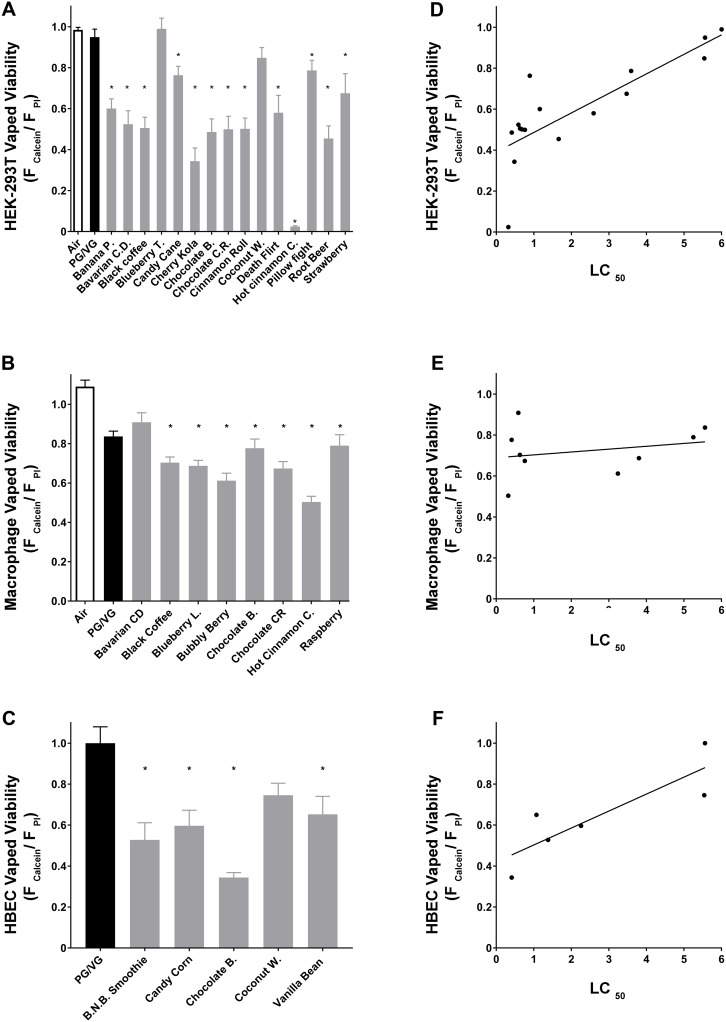
Toxicity of “vaped” versus neat e-liquids.(A) Mean normalized viability of HEK293T cells following exposure of vaped e-liquids. N ≥ 5 per treatment. (B) Mean normalized viability of primary human alveolar macrophages following exposure of vaped e-liquids. N ≥ 5 per treatment. (C) Mean normalized viability of HBECs following exposure to vaped e-liquids. N ≥ 5 per treatment. (D) Graph showing HEK293T vaped viability versus HEK293T toxicity (LC50) obtained using neat e-liquids. Linear regression R2 = 0.66. (E) Graph showing primary human alveolar macrophage vaped viability versus HEK293T toxicity (LC50). Linear regression R2 = 0.06. (F) HBEC viability using vaped e-liquids versus HEK293T toxicity (LC50). Linear regression R2 = 0.74. * = p < 0.05 different from control. For A, B, and C we performed statistical analysis using one-way ANOVA followed by Dunnett’s Test. B. N. B. Smoothie, Chocolate B., and Coconut Water. Raw data are available in S5 Data. B. N. B. Smoothie, Banana Nut Bread Smoothie; Chocolate B., Chocolate Banana; HBEC, human bronchial epithelial cells; HEK293T, human embryonic kidney 293 cells; LC50, concentration at which a given agent is lethal to 50% of the cells.